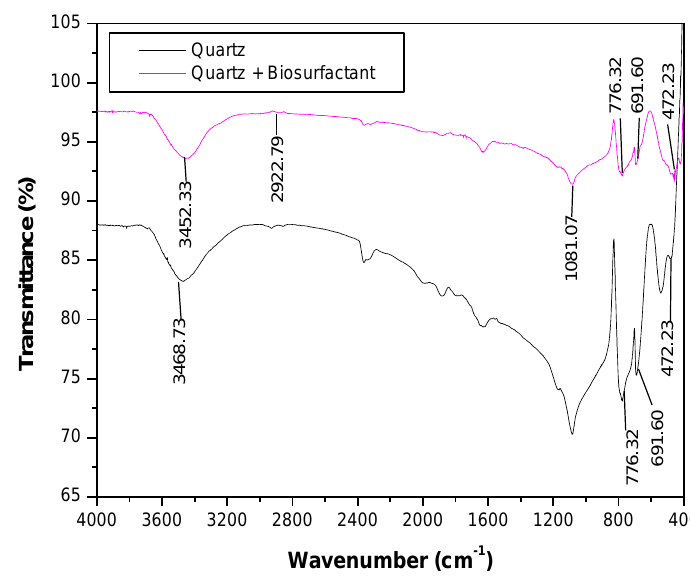
Figure 4. FTIR spectra of quartz before and after interaction with biosurfactant.